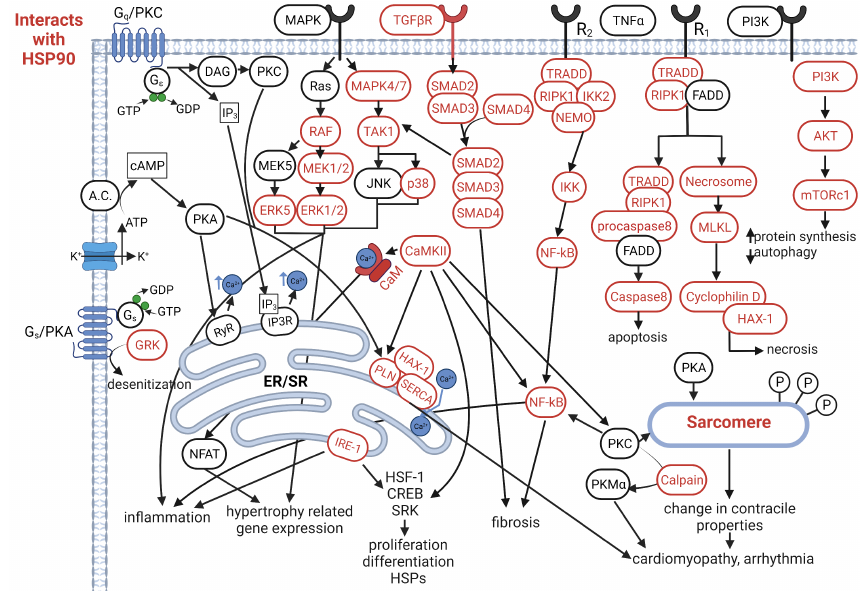
Figure 2. Signaling pathways related to cardiomyopathy. Proteins highlighted in red interact with